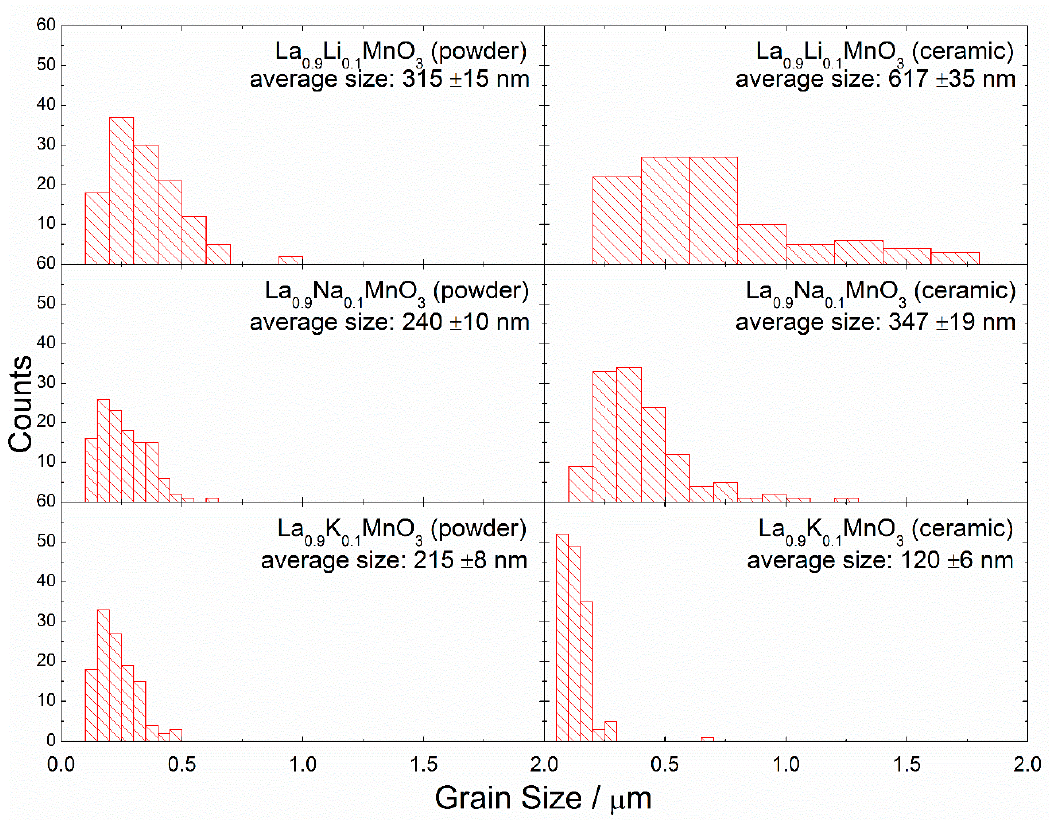
Figure 3. Distribution of the grain sizes in the La 0.9 A 0.1 MnO 3 (A: Li, Na, K) nanopowders and nanoceramics .